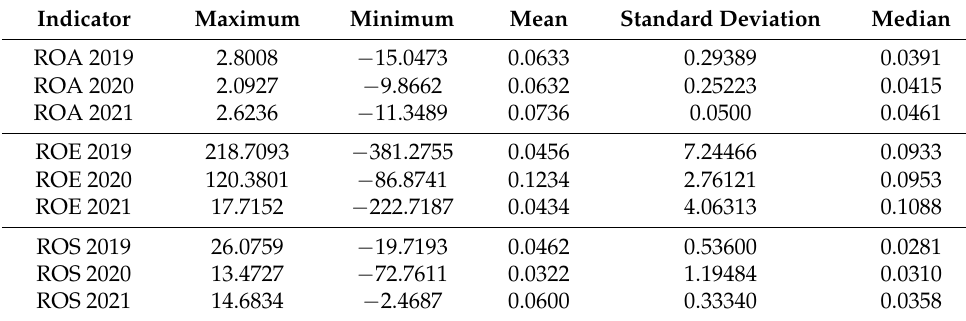
Table 3. Descriptive statistics for medium-sized companies. Source: own research. Indicator